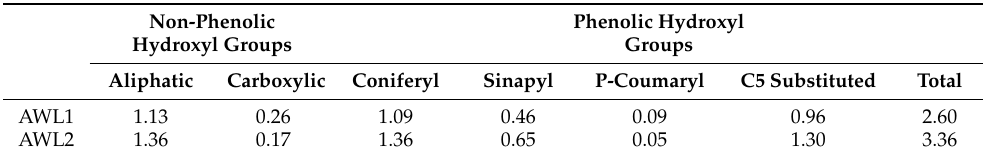
Table 2. Aliphatic, carboxylic, and phenolic hydroxyl group contents of unmodified acid-washed lignin samples ( ± 0.03 mmol/g).